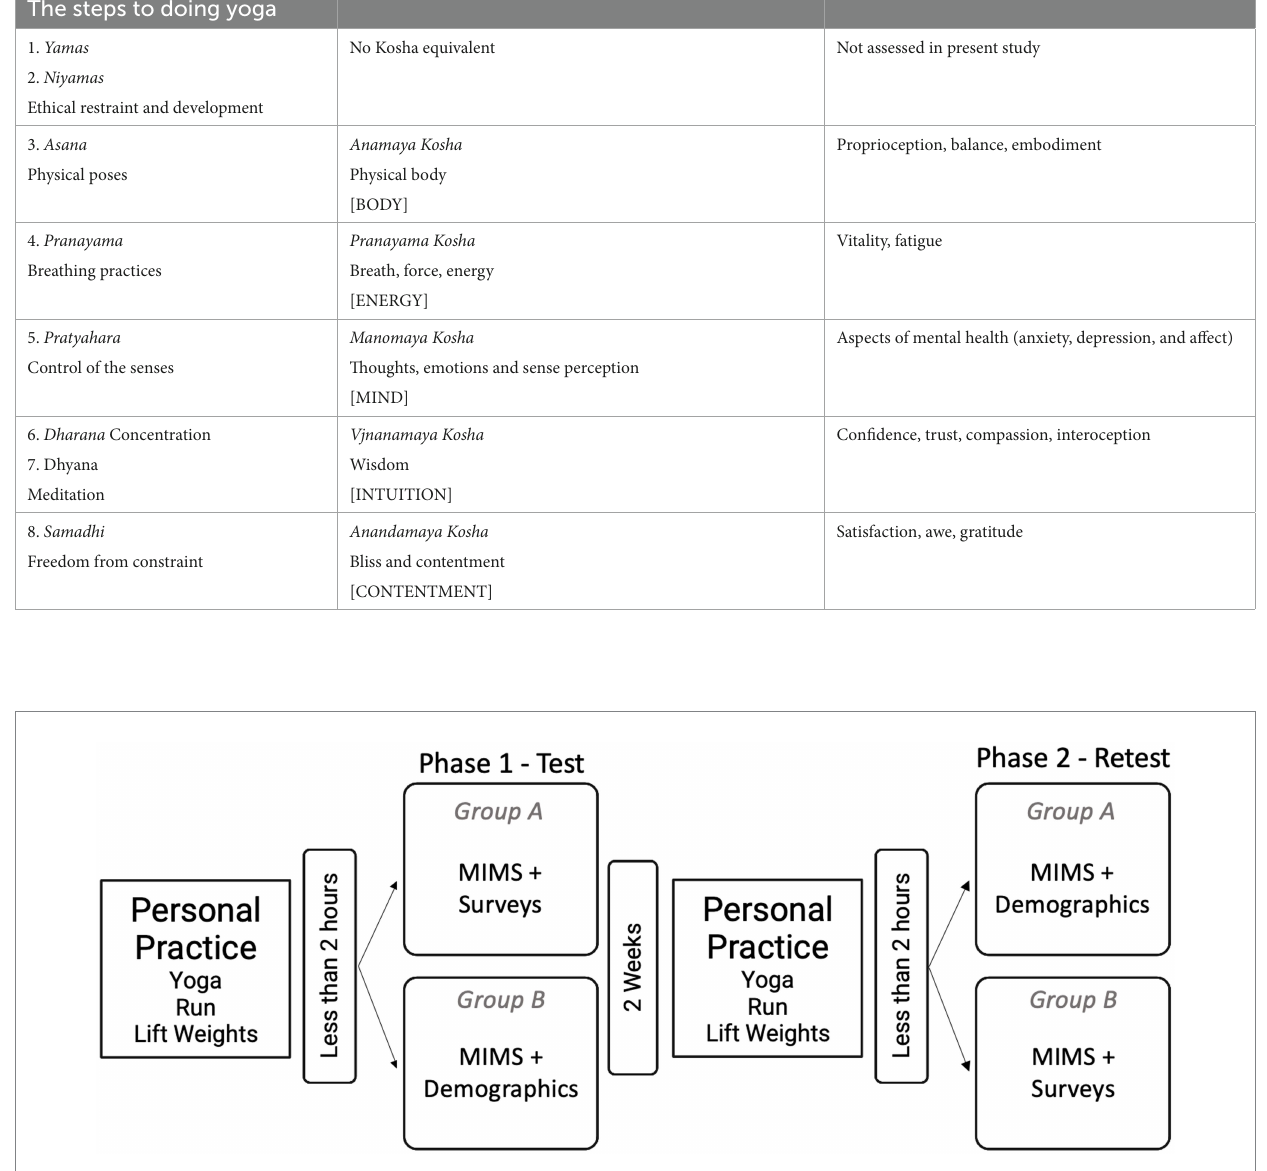
FIGURE 2 Study design, including study elements and